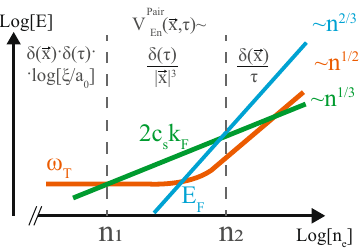
Fig. 2 | Density-dependence of the form of the effective energy- fl uctuation mediatedelectron-electronattraction V Pair En ð x τ Þ ,Eq.(11). The colored linesshow the three energy scales relevant for pairing: ω T ( n e ) (Eq. (6)), related to the polar ordercorrelationlength ξ = c s / ω T ( n e ),thecharacteristicmomentum-exchangescale 2 c s k F and the Fermi energy E F , the characteristic energy exchange scale. In each region (separated by gray dashed lines) the dominant scale determines the effec- tiveformoftheinteraction.Atlowdensities n e ≪ n 1 ≈ 1 approximated with a local one. On increasing the density ð n 1 ≪ n e ≪ n 2 =3 π 2 ð 4 m * c s _ Þ the momentum dependenceof the interaction becomes prominent fi rst,